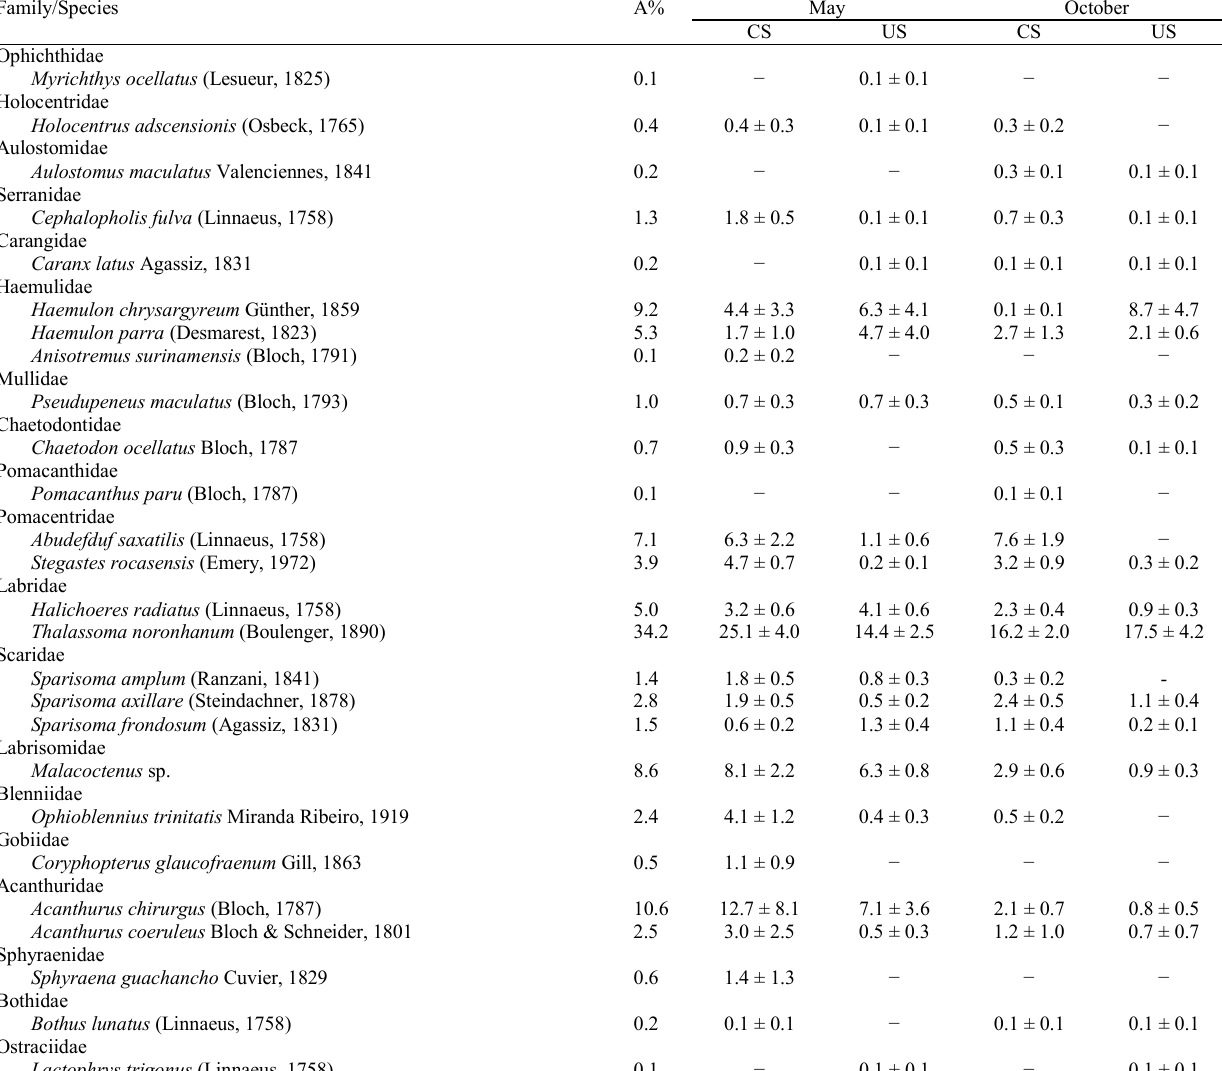
Table 4. Relative abundance (A%) and mean values (±SE) of fish abundance from 15 permanent consolidated substratum (CS) stations and 15 permanent unconsolidated substratum (US) stations from two sampling periods (May and October).